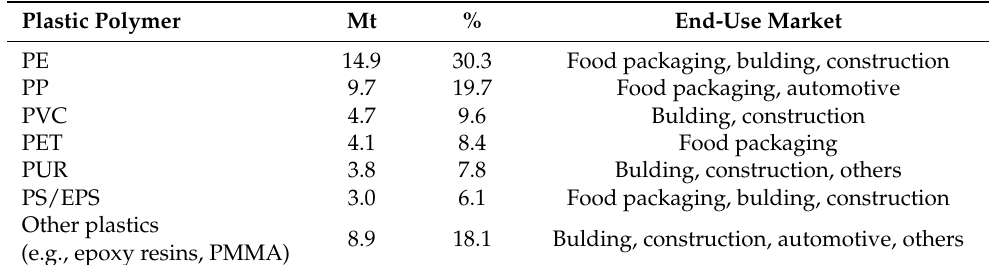
Table 1. European plastic demand in 2020. The column ‘Mt’ presents the annual demand of plastic expressed in million tons (total: 49.1 Mt). For further details, please refer to [5]. EPS: expandable polystyrene; PMMA: polymethylmethacrylate.